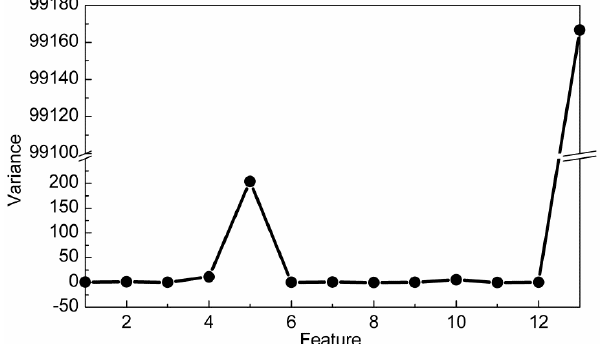
Figure 3. The variances of 13 features on the wine data.